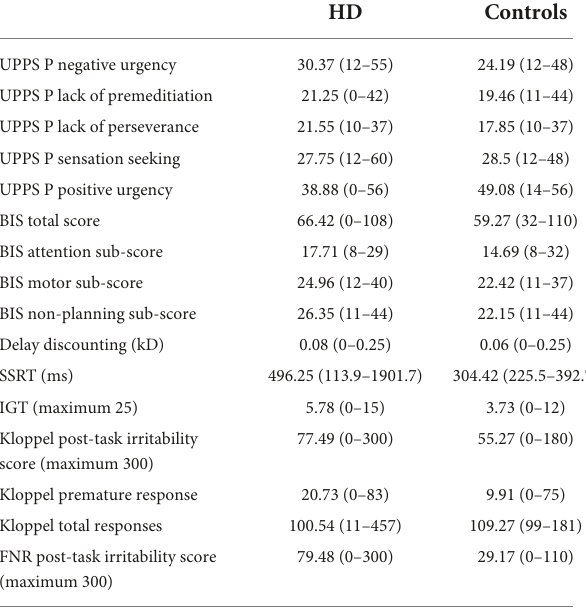
TABLE 2 Questionnaire and task scores.